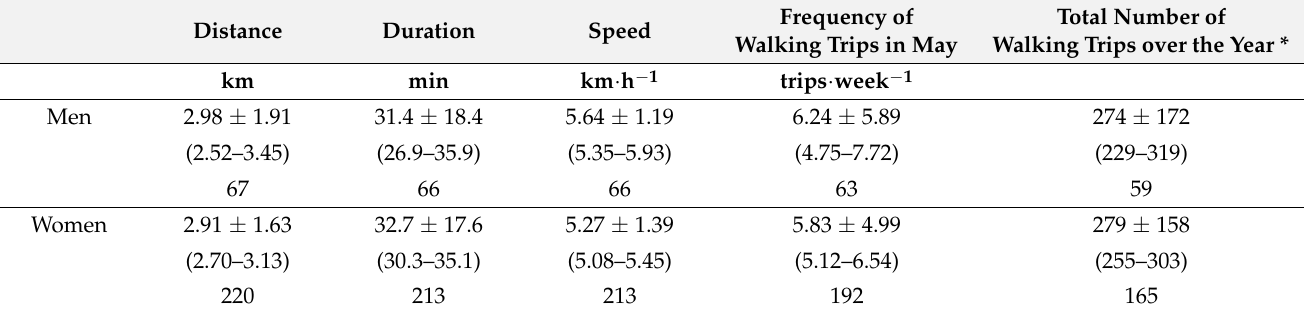
Table A1. Descriptive characteristics of the walking commuting trips (mean ± SD, (95% CI) and n